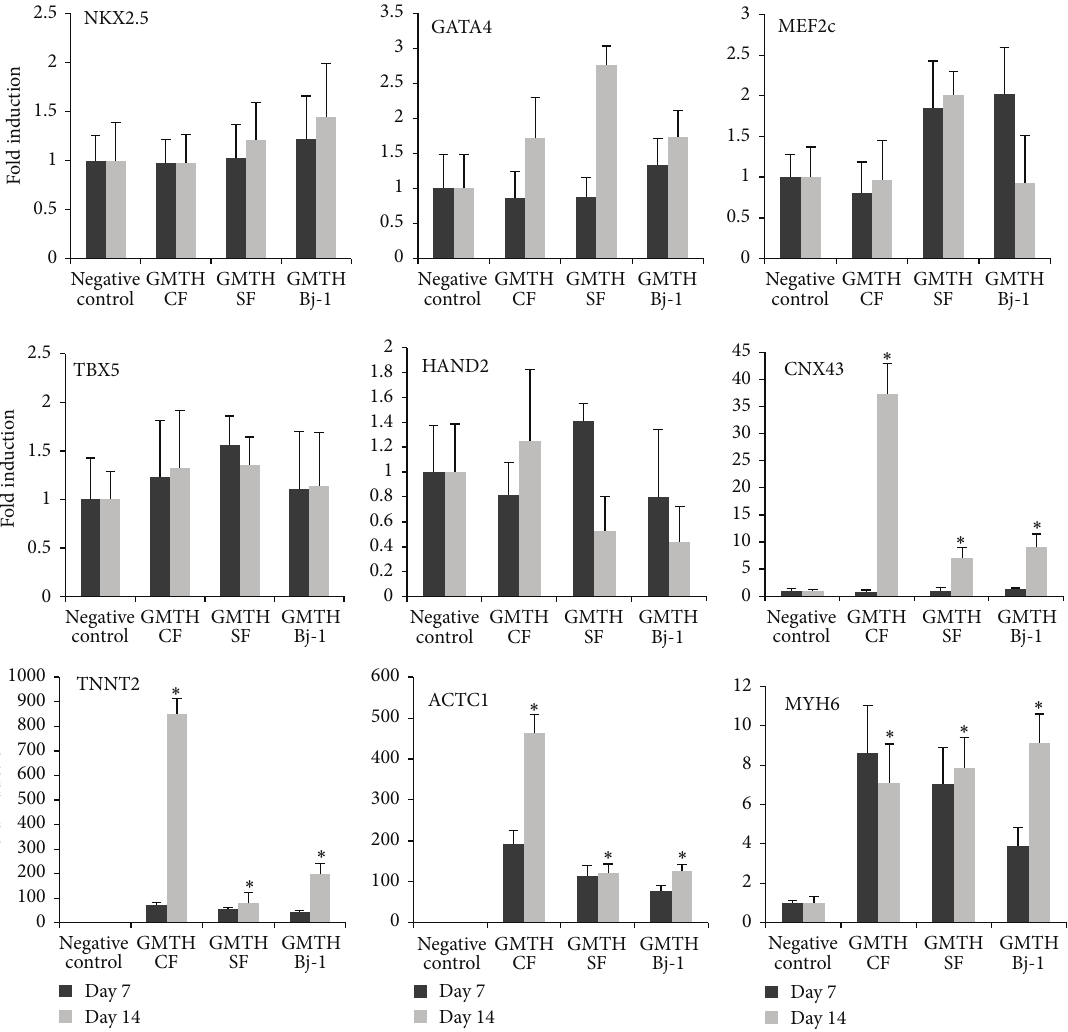
∗∗ Figure 3: Characterization of GHMT transduced cells. qRT-PCR was performed at day 7 and at day 14 from transduction. Early endogenous cardiac marker genes (Nkx2.5, Gata4, and Mef2c-Tbx5-hand2) and late cardiac marker genes (CNX43, TNNT2- ACTC1 and MYH6) were analysed. Fold induction of mRNA expression in transduced cells compared to the controls (cells transduced only with 𝛼 -MHC-GFP vector). The expression of late cardiac markers identified canine-induced cardiac-like myocytes (ciCLMs) in the transduced cell populations; 𝑛 = 5 , 2-way ANOVA test, ∗ 𝑝 < 0.01